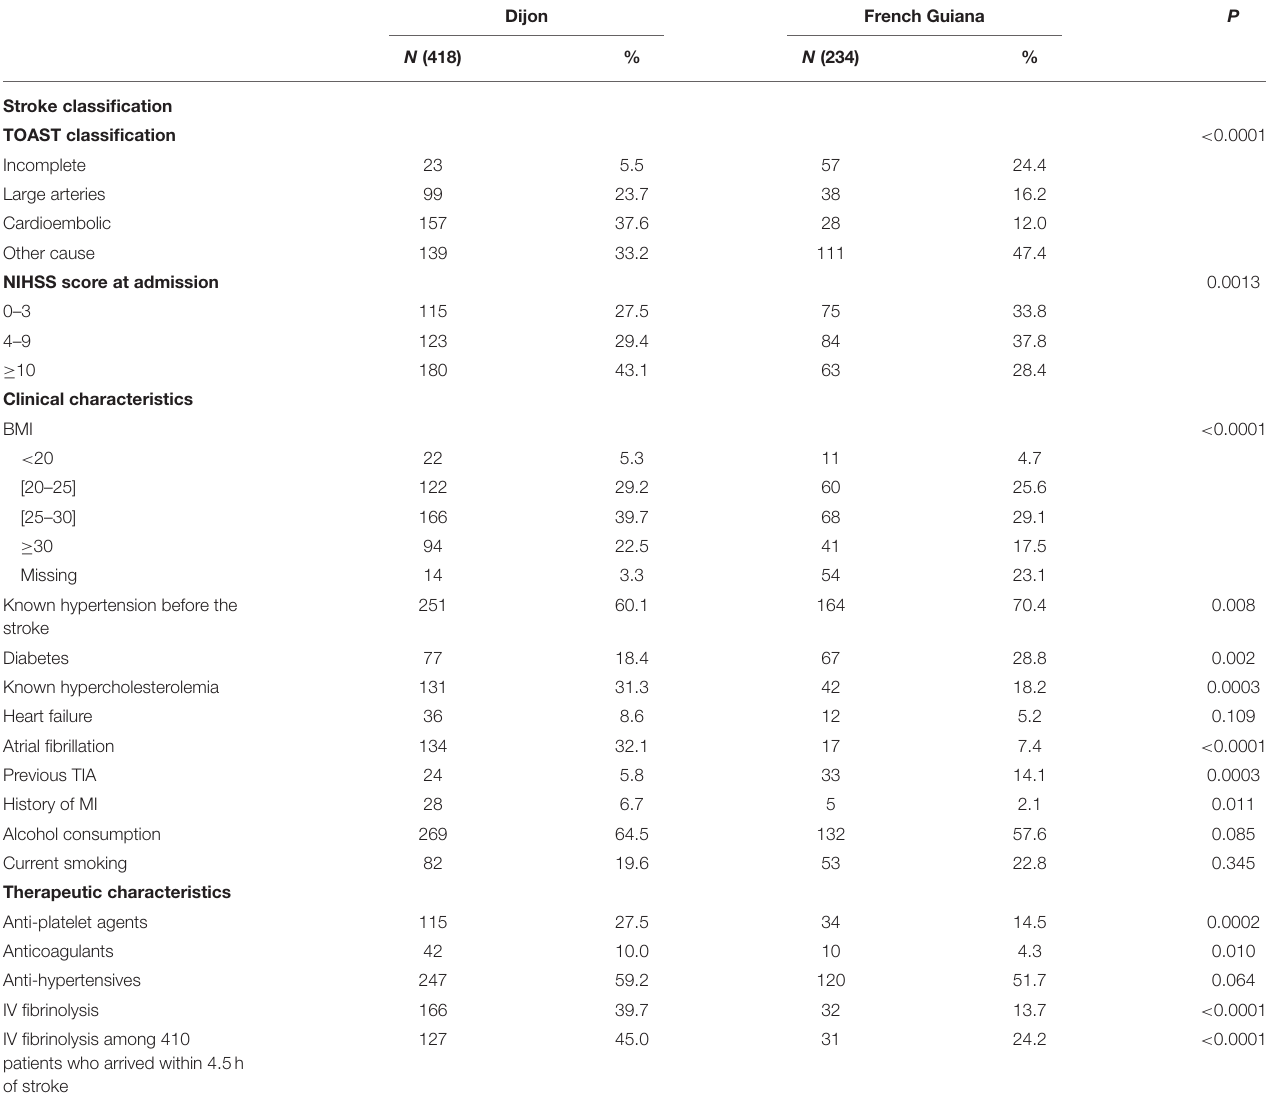
TABLE 1 | Stroke presentation, risk factors, and care comparisons between French Guiana and Dijon. Dijon French